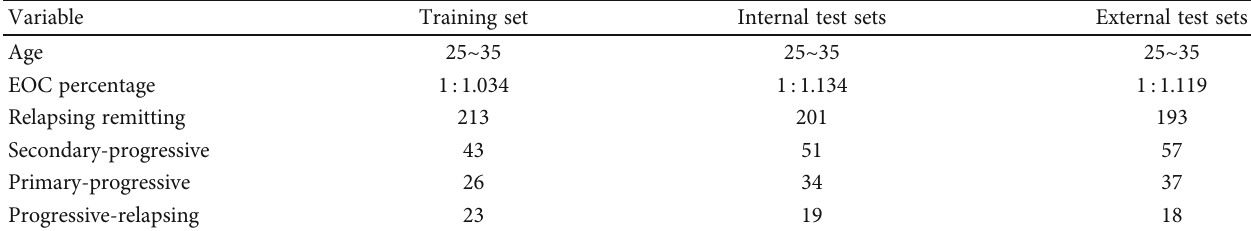
Table 2: Clinical information of patients in the training set, internal test set, and external test